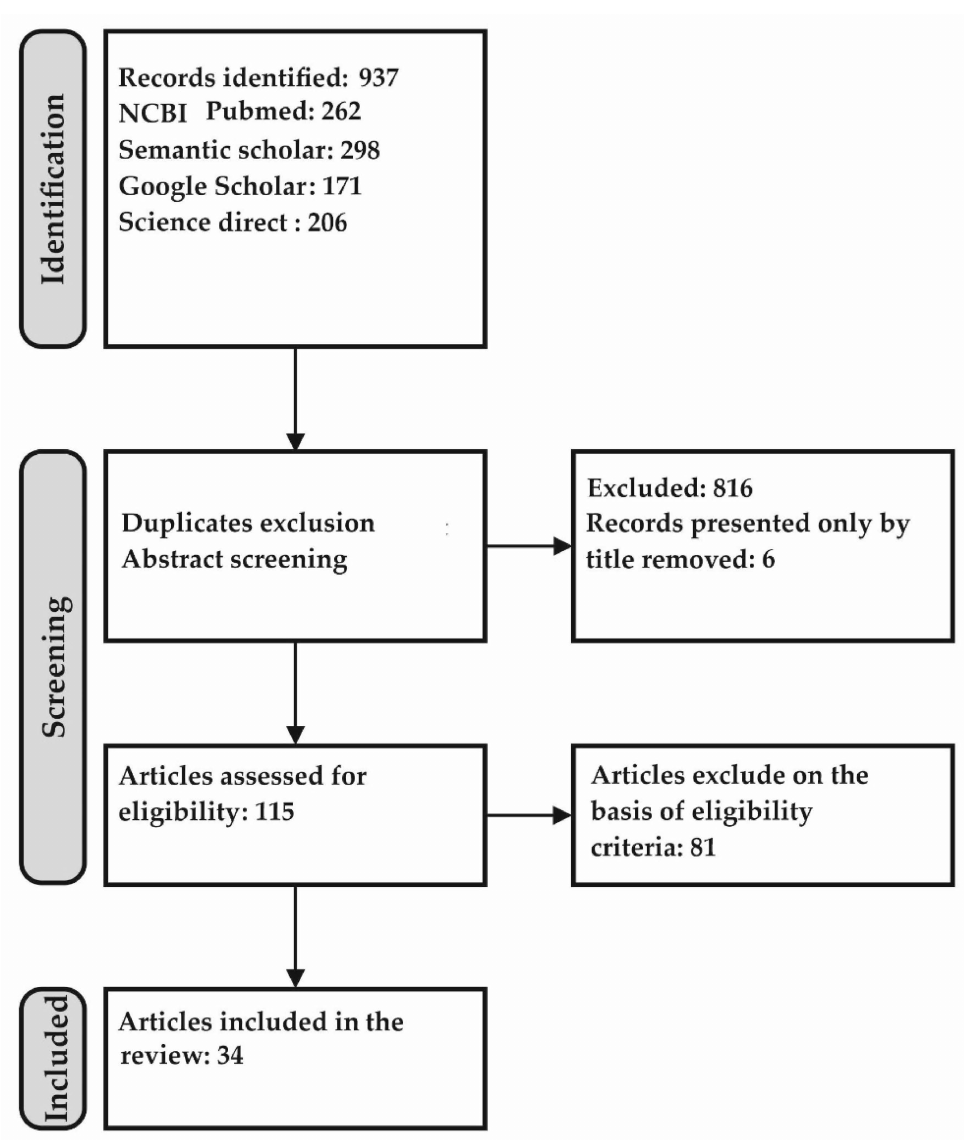
Figure 1. Flow chart of publication selection for the